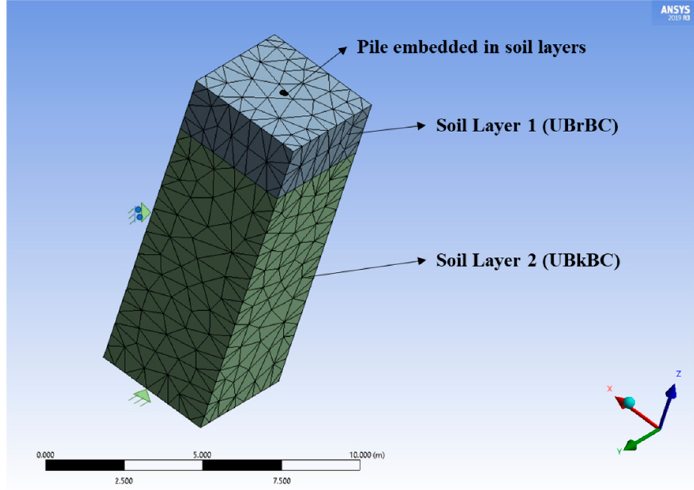
Figure 16. A mesh representation of the FEM Model (ANSYS 2019 R3).